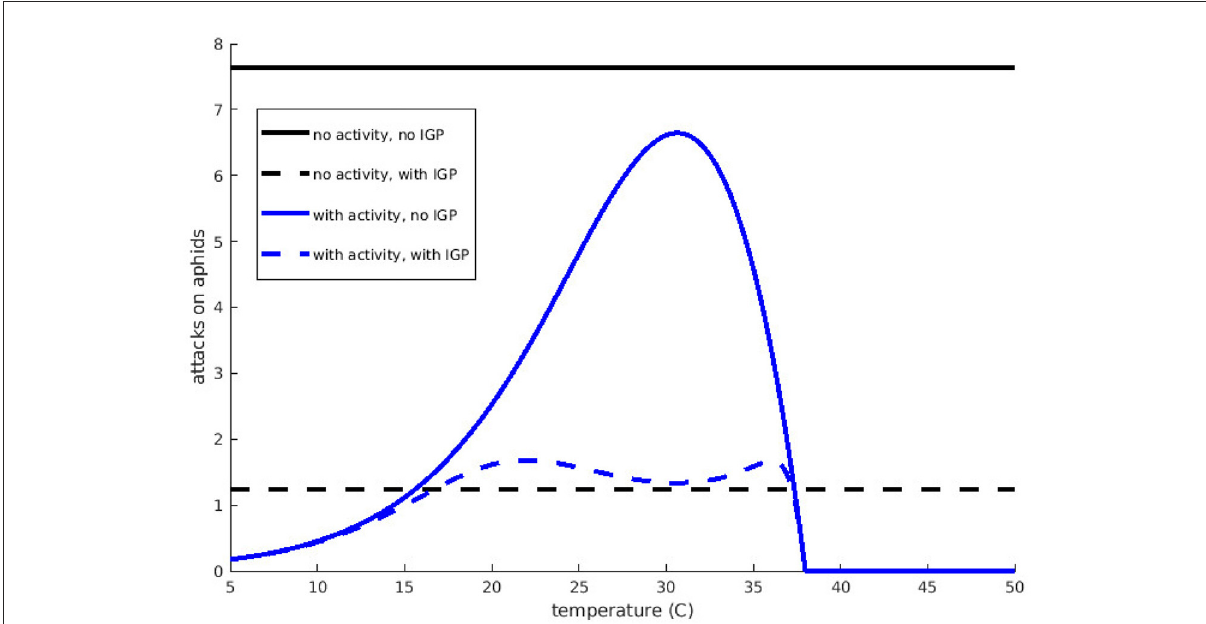
FIGURE4 Community-level attack rates on aphids by the average optimal predator community, plotted against temperature. Solid lines denote potential attack rates and dashed lines denote effective attack rates accounting for interference due to intraguild predation. Black lines do not incorporate temperature-dependent activity levels (with constant activity ν j ( T ) = 1) and blue lines incorporate temperature-dependent activity levels (with varying activity ν j ( T